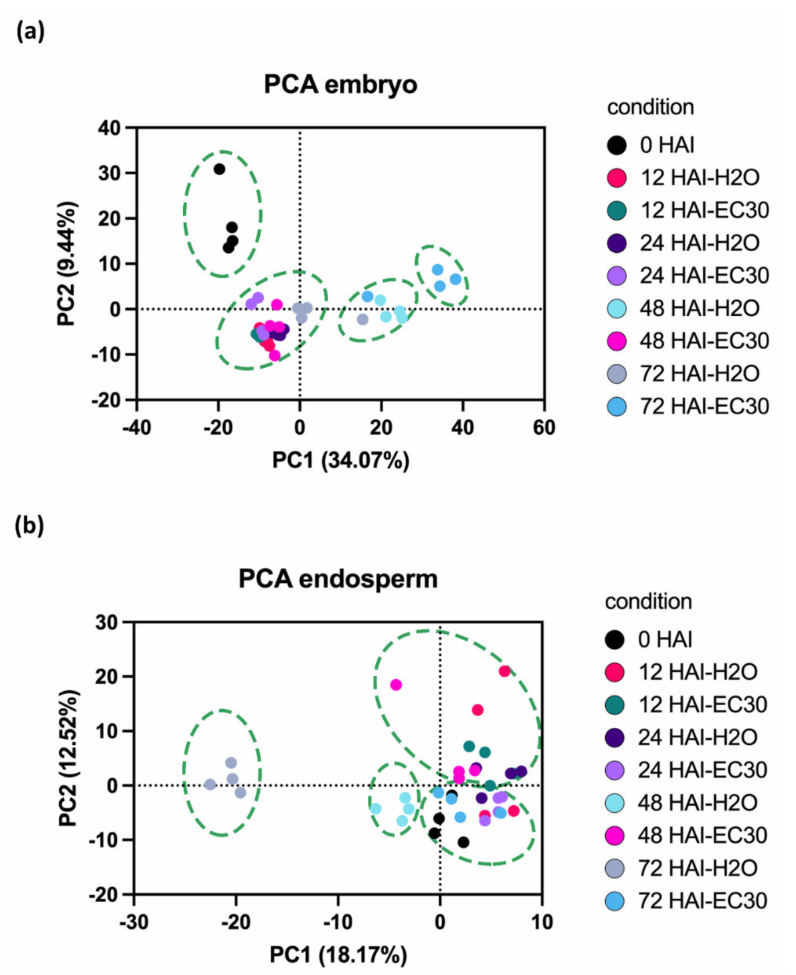
Figure 3. PCA was conducted on protein abundances of the different stages during germination. Each dot corresponds to a single replication ( n = 4). Protein loadings of the ( a ) embryo and the ( b ) endosperm on PC1 and PC2 were projected in the two-dimensional plan. The different stages were coloured as follows: black circle = 0 HAI, rhodamine = 12 HAI-H 2 O, pine green = 12 HAI-EC30, blue violet = 24 HAI-H 2 O, purple = 24 HAI-EC30, turquoise = 48 HAI-H 2 O, pink = 48 HAI-EC30, grey = 72 HAI-H 2 O, cyan = 72 HAI-EC30. The separated clusters are indicated by the green dashed ellipsoid